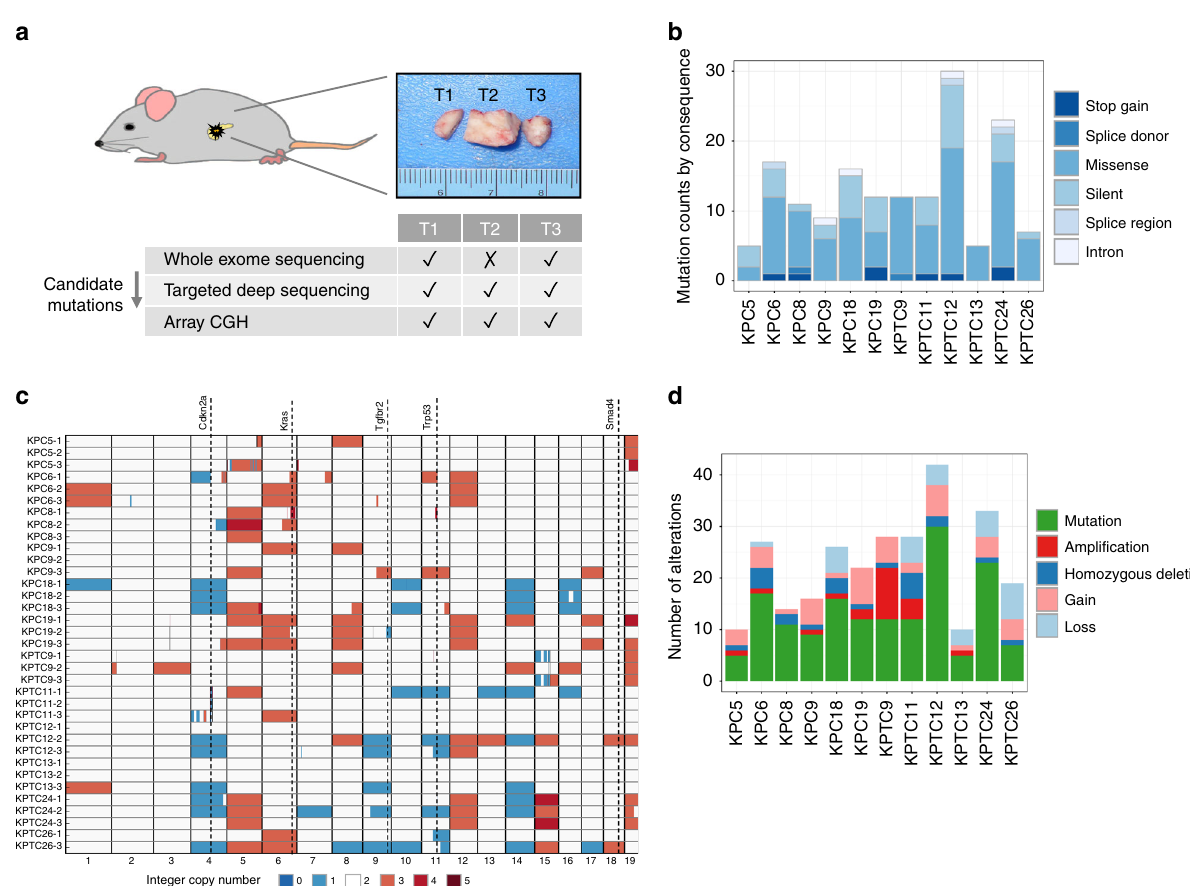
Fig. 1 Genomic characterization of six KPC and six KPTC mice. a The tumor tissue collected from the pancreata of each moribund mouse was divided into three regions designated T1 – T3. The DNA from tumor regions T1 and T3 was subject to whole exome sequencing. Candidate somatic mutations identi fi ed by whole exome sequencing were subsequently validated in all three regions, using targeted amplicon sequencing. Array CGH was applied to the DNA from the three tumor regions. b The frequency of mutations with respect to predicted consequence type in each mouse. Values represent those of all three samples per mouse tumor. c Somatic copy number pro fi le. The tumor-to-normal copy ratios measured by array CGH were scaled to correct for tumor purity and rounded up to closest integer level. Gain of chr 5, 6, 8, 12, 19 and loss of chr 4, 9, 11, 14 were the most frequent somatic copy number events. d The frequency of mutations, focal ampli fi cations and deletions, and large-scale chromosomal gains and losses. Focal and large-scale copy number aberrations were compared across tumor regions from each mouse to identify unique